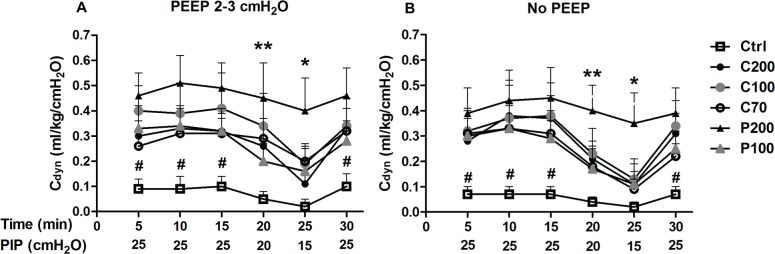
Poractant alfa and Calsurf in preterm rabbits with primary surfactant deficiency in PIP loop experiment.The dynamic compliance of the respiratory system (Cdyn) was determined during mechanical ventilation with a standardized PIP loop (25-25-25-20-15-25 cmH2O, each PIP for 5 min). Two independent experimental sessions, with the PEEP set at 2–3 cmH2O (A) and without PEEP (B) were conducted. Symbols and ticks represent mean±SD. Group definitions for symbols: P200, 200 mg/kg of Poractant alfa, black triangles; P100, 100 mg/kg of Poractant alfa, grey triangles; C200, 200 mg/kg of Calsurf, black circles; C100, 100 mg/kg of Calsurf, grey circles; C70, 70 mg/kg of Calsurf, white circles; Ctrl, untreated animals served as controls, white squares; (n = 10 animals in each group). One-way ANOVA with S-N-K post-hoc test was used for between-group comparisons. # P<0.01 vs. all surfactant-treated groups; ** P<0.01, * P<0.05 vs. Ctrl group.